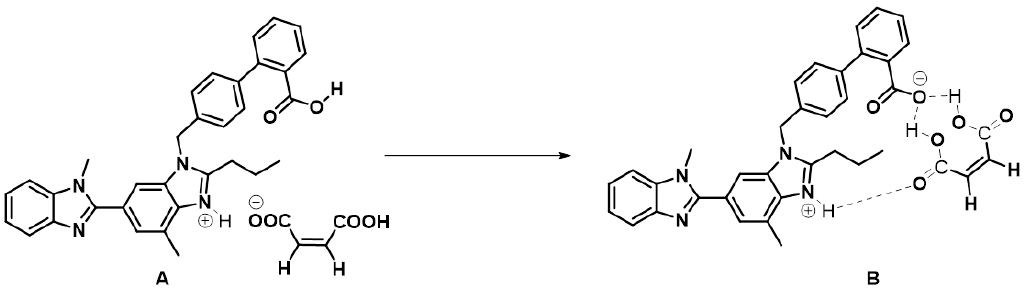
Figure 18. Maleic-acid promoted conversion of ( A ) to ( B ) during the cocrystal formation as hypothesized from the NMR data.